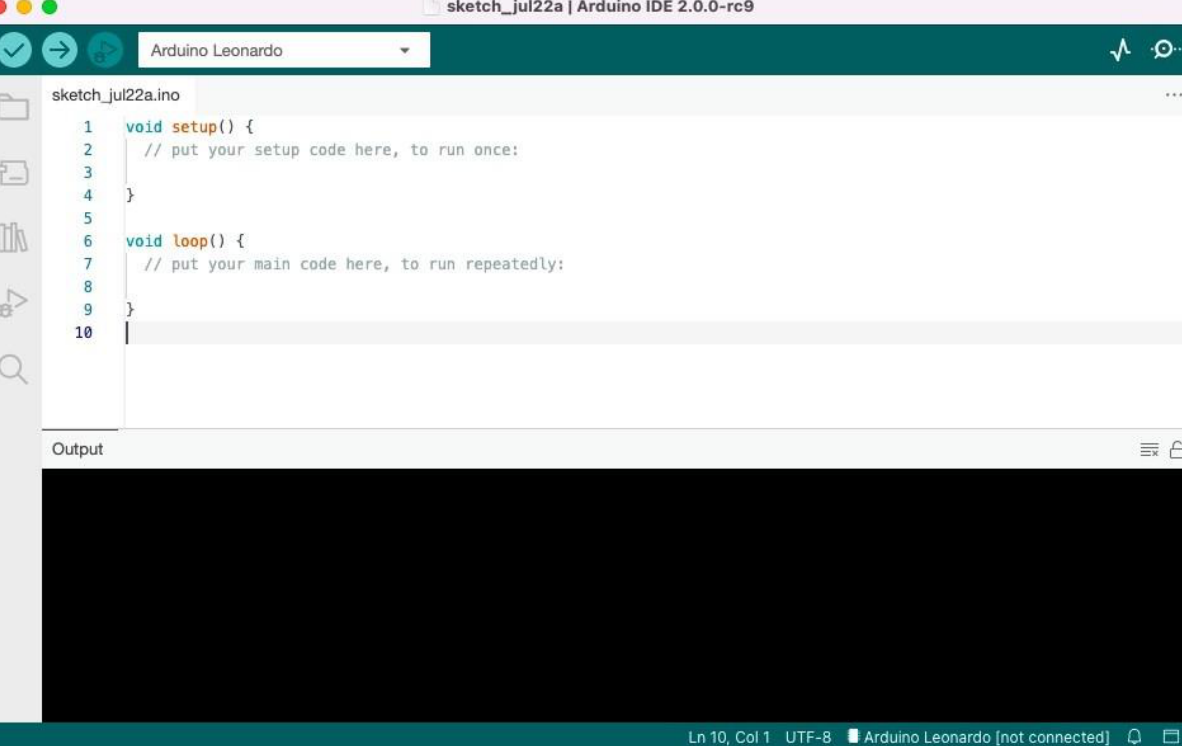
Figure 8. Arduino IDE.